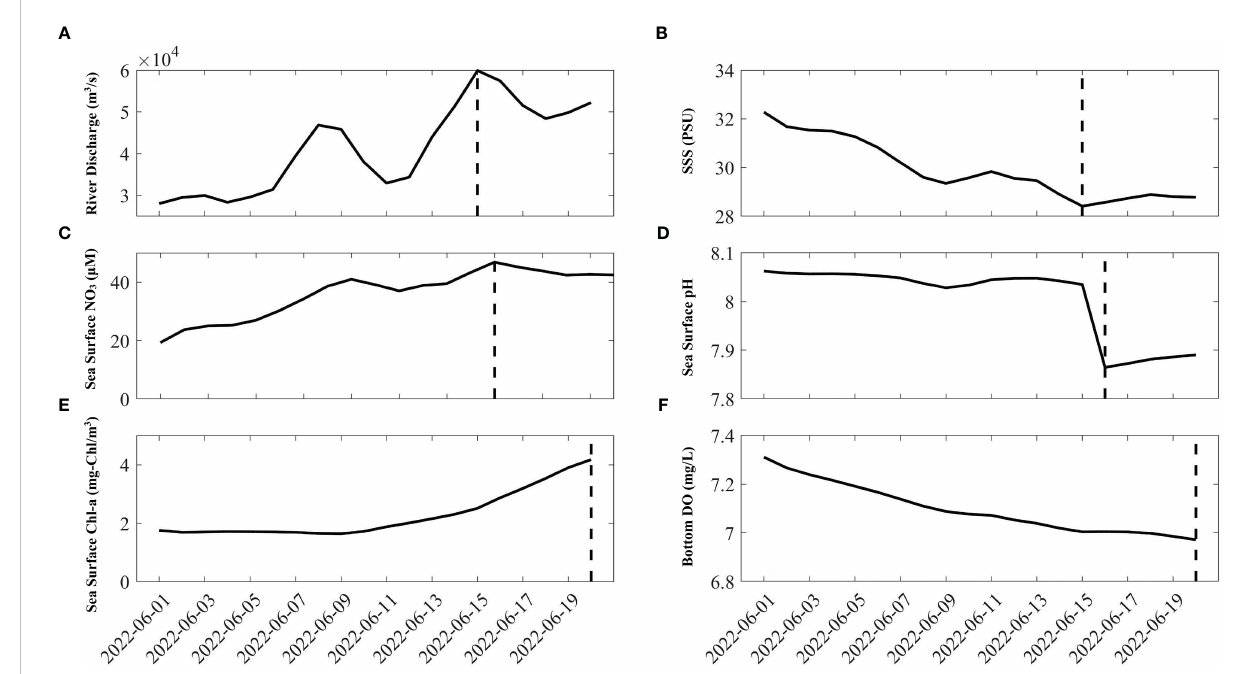
FIGURE 12 The river discharge (A) and CGEEPS predicted SSS (B) , Sea surface NO 3 (C) , pH (D) , Chlorophyll (E) , and bottom DO (F) from June 01, 2022, to June 20, 2022, when the fl ood happened. Vertical lines denote timing of maximum river runoff, sea surface NO 3 , chlorophyll, and minimum sea surface salinity, surface pH and bottom